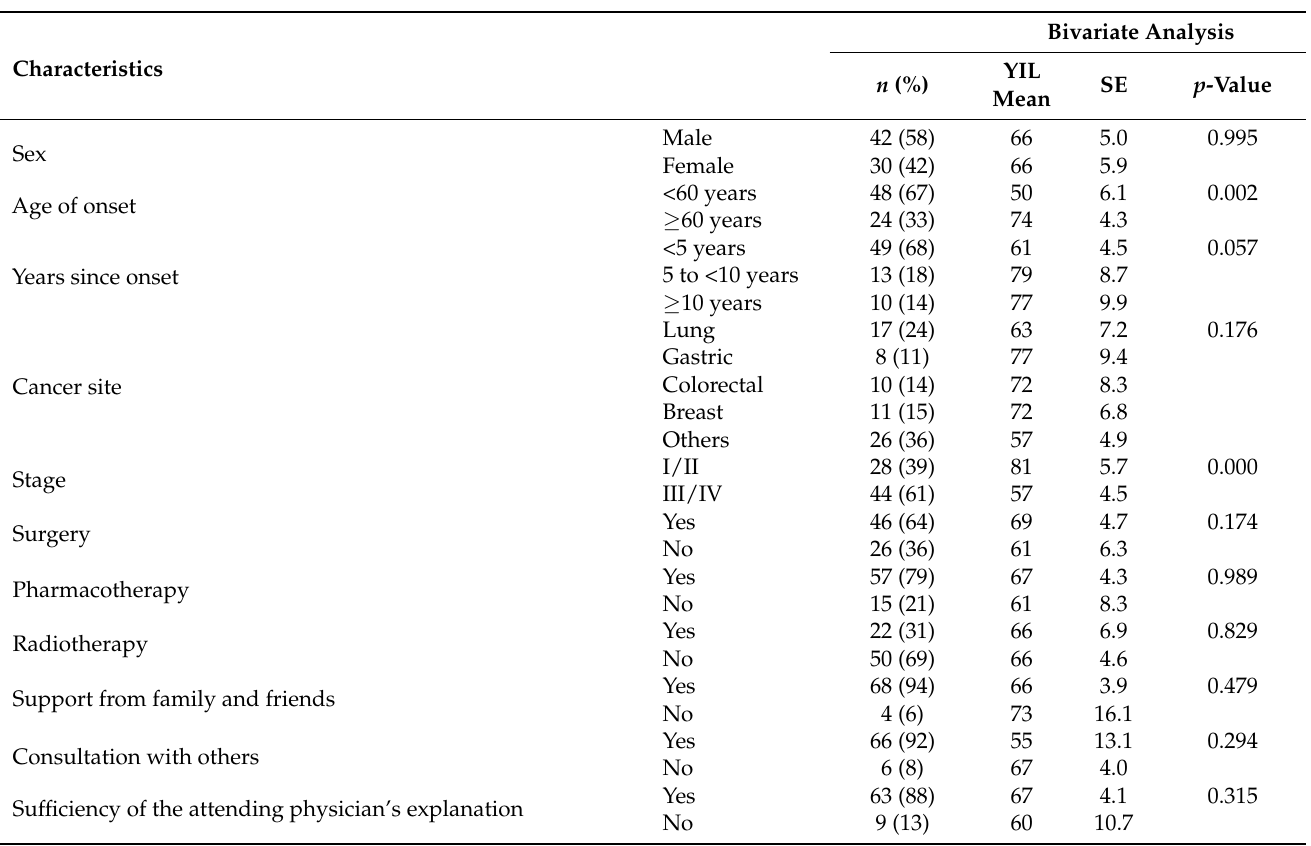
Table 1. Characteristics of the participants ( n = 72) and bivariate analysis results of the income change: YIL %(pre-diagnosis is set at